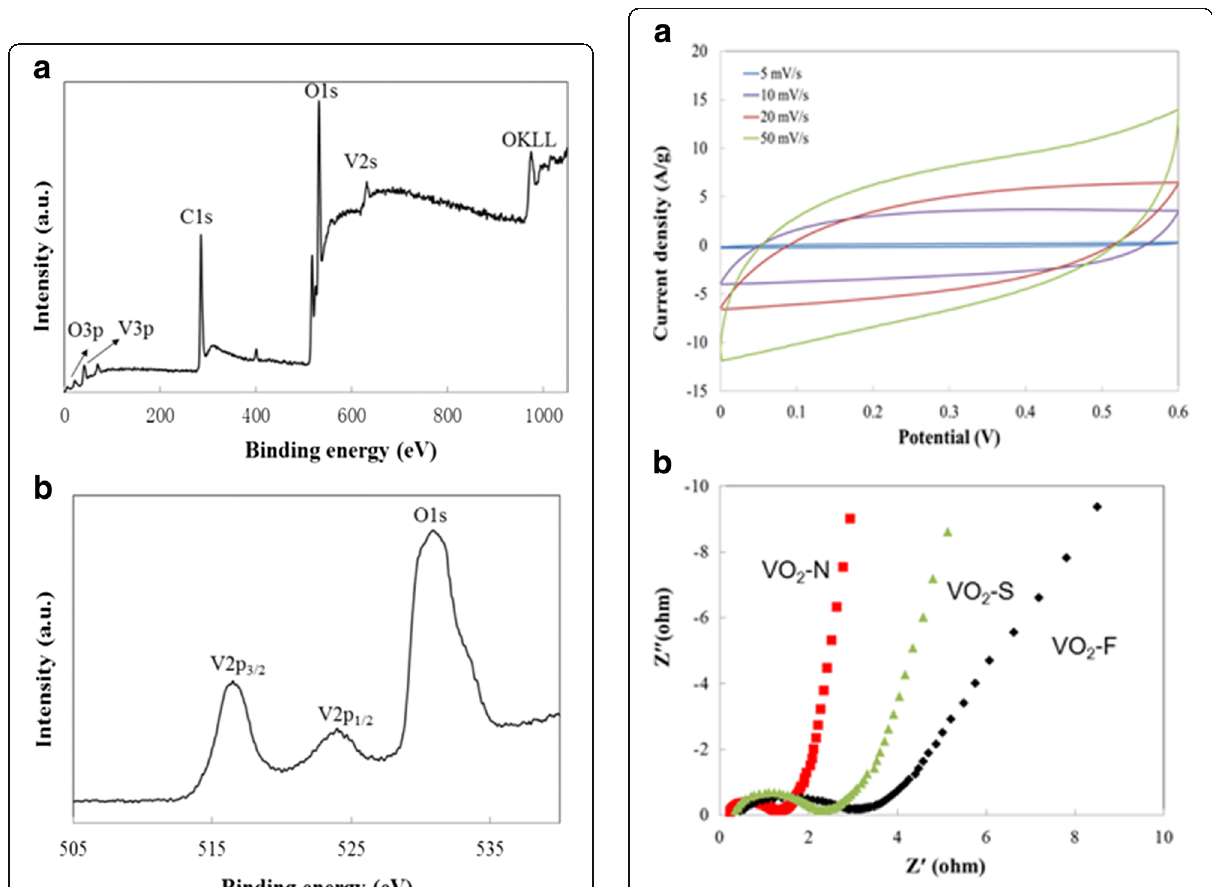
Fig. 4 CV curves at the scan rates of 5 – 50 mV/s ( a ) and EIS spectra of 2D VO 2 microarrays ( b